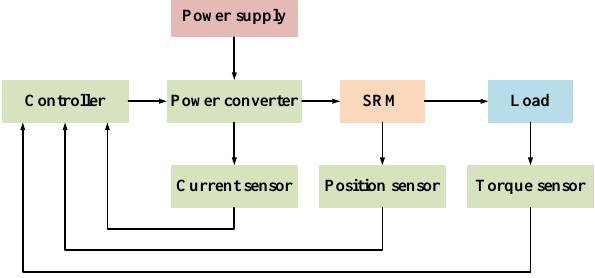
Figure 1. SRM speed control system block diagram.